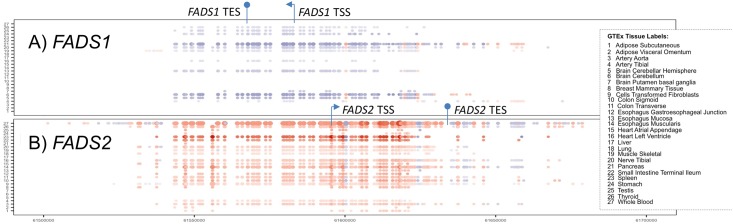
FADS1 and FADS2 cis-eQTLs.Significant eQTLS (FDR<0.05) associated with gene expression of FADS1 (A) or FADS2 (B) identified in 27 human tissues from GTEx. The significance of the detected association is represented as the size of the circle (larger the circle, more significant the result), and the color represents the direction of effect of the alternate (alt) allele (red for increased transcription with alt allele, blue for decreased transcription). FADS1 and FADS2 gene transcription start sites (TSS) and transcription end sites (TES) illustrate the location of FADS1 and FADS2 genes relative to the cis-eQTLs.